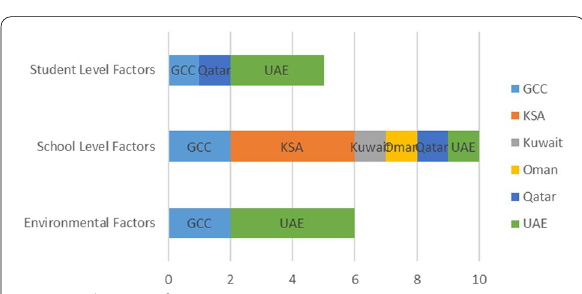
Fig. 14 Thematic focus per GCC